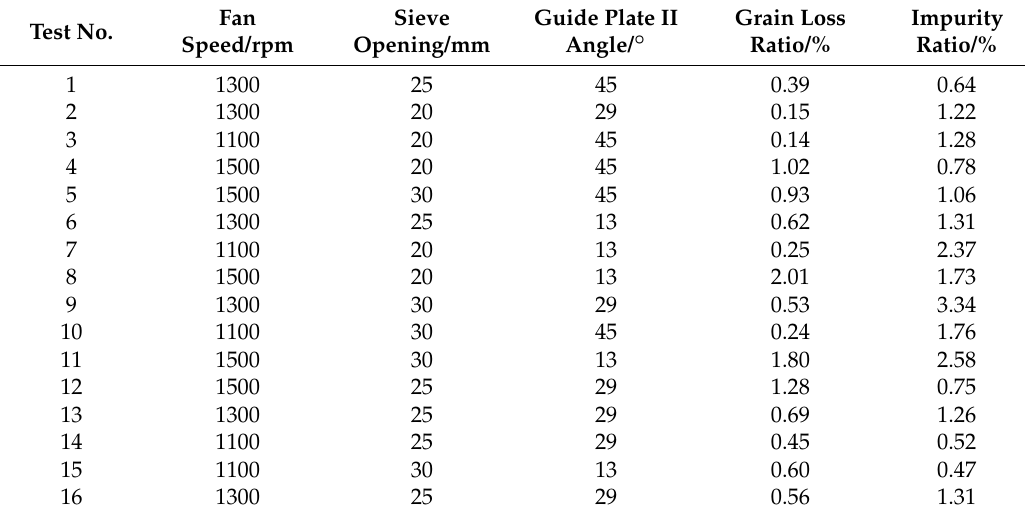
Table 3. Response surface experiment results on cleaning performance.